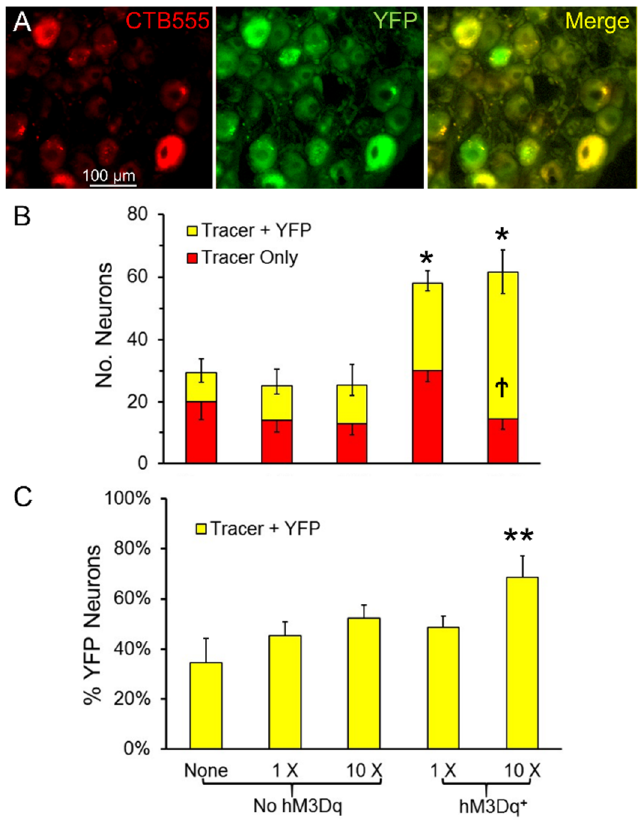
Figure 4. ( A ) Double labeled L4 dorsal root ganglion (DRG) neurons (40×). ( B ) The mean number (±SEM, N = 4) of L4 DRG neurons labeled four weeks after nerve injury. The same color coding and error bars are used as in Figure 3. ( C ) The mean proportion of double labeled DRG neurons (±SEM) is shown for the same five groups. * = p < 0.05 vs. No hM3Dq for all cells, ** = p < 0.05 vs. all other groups, † = p < 0.05 vs. all other groups for Tracer + YFP cells.